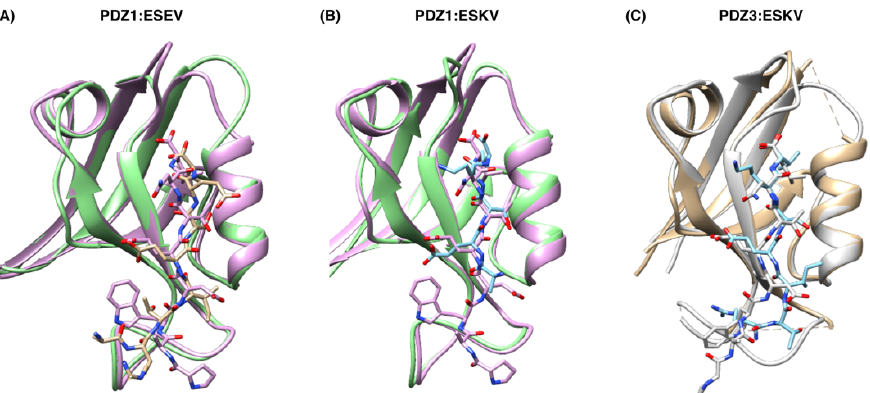
Figure 4. Superimposition of SCRIB PDZ1:NS1 complexes with previously determined SCRIB PDZ structures in complex with host cell β -pix PBM peptides, represented as ribbons and sticks. ( A ) PDZ1:ESEV (green:yellow) superimposed with SCRIB PDZ1: β -pix (pink, PDB ID 5VWK), RMSD is 0.77 Å. ( B ) SCRIB PDZ1:ESKV (green:light blue) superimposed with SCRIB PDZ3: β -PIX (pink, PDB ID 5VW1) and SCRIB PDZ3apo (forest green) RMSD is 0.75 Å. ( C ) PDZ1:ESKV Chain A (gold:light blue) superimposed with SCRIB PDZ3: β -PIX (light grey, PDB ID 5VW1), RMSD is 0.57 Å.